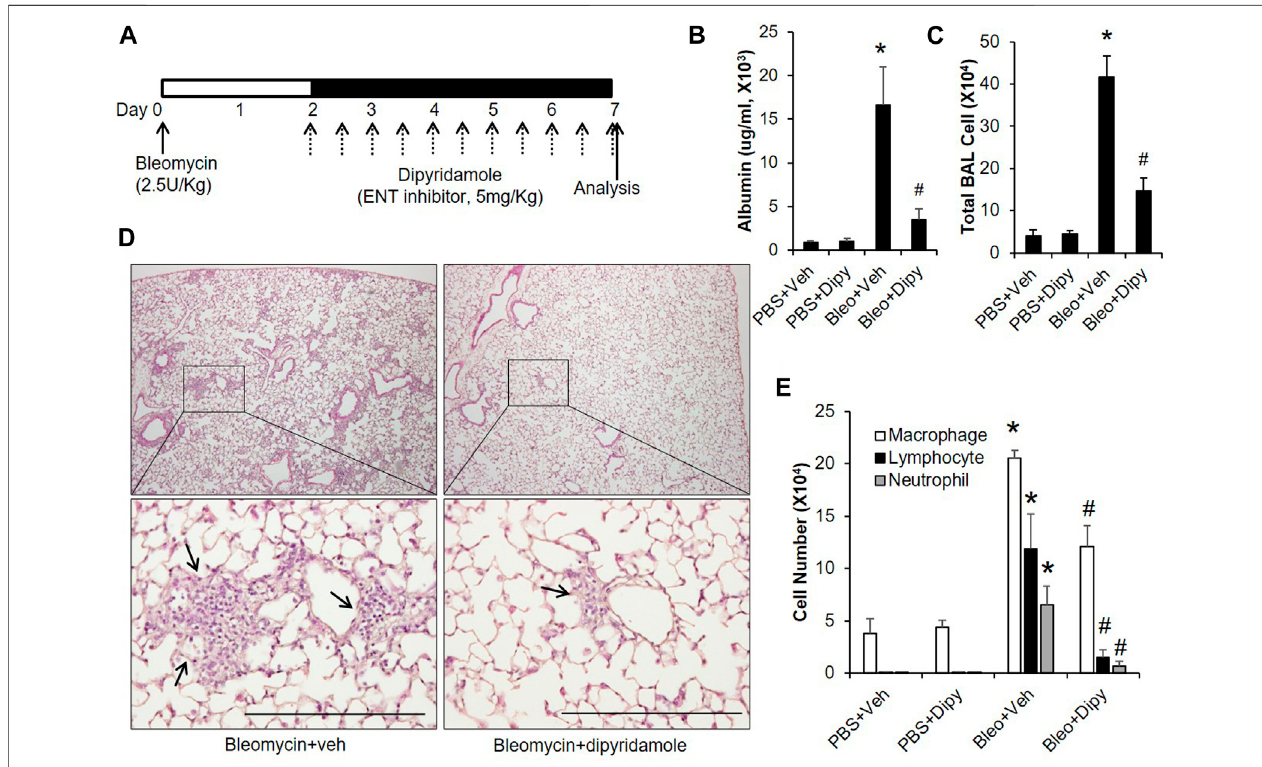
FIGURE 4 | Therapeutic effect of dipyridamole on established ALI. (A) A diagram showing how mice were treated with dipyridamole and bleomycin. Mice injected withsamevolumeofVehiclewereusedascontrol. (B) BALalbuminlevelsweremeasured fromdifferenttreatmentgroups. (C) BALtotalcellnumberswerecounted. (D) Lungsfrombleomycinand/ordipyridamoletreatedmiceweresectionedandstainedwithH&E.Representativepictureswereshown.Scalebar (cid:2) 500 µM. (E) Differential assay was performed to determine the degree of macrophage, lymphocyte and neutrophil traf fi cking into the lungs. n ≥ 5, * p < 0.05 vs. PBS. # p < 0.05 vs. bleomycin using one way ANOVA followed by Bonferroni ’ s multiple comparisons test. Scale bar (cid:2) 200